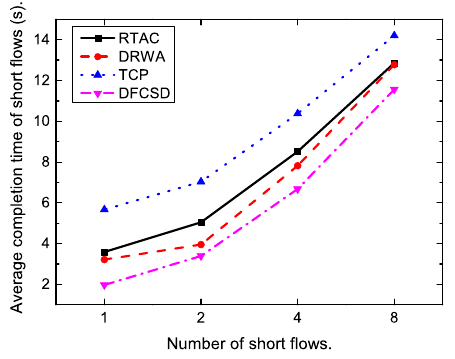
Figure 13. The FCT of the short flows when the number of the concurrent short flows varies from 2 to 8.